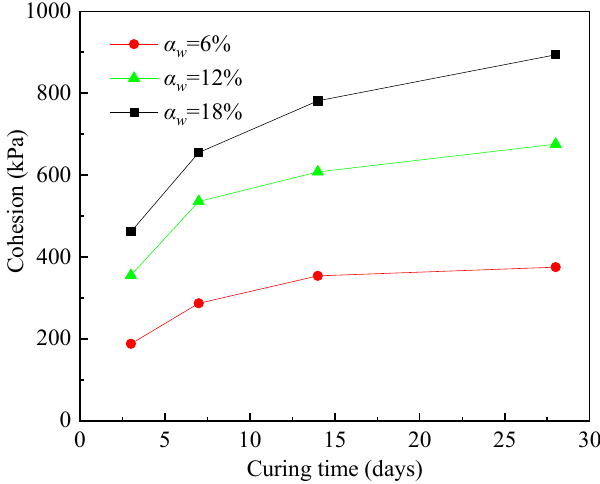
Figure 13. Correlation between the cohesion and cement content.